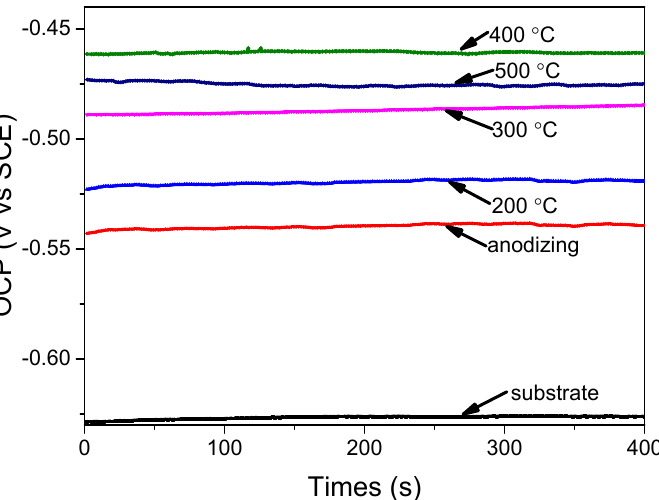
Figure 5. The open circuit voltage of Al substrate, anodic coating before and after being treated at 200 °C, 300 °C, 400 °C, and 500 °C.